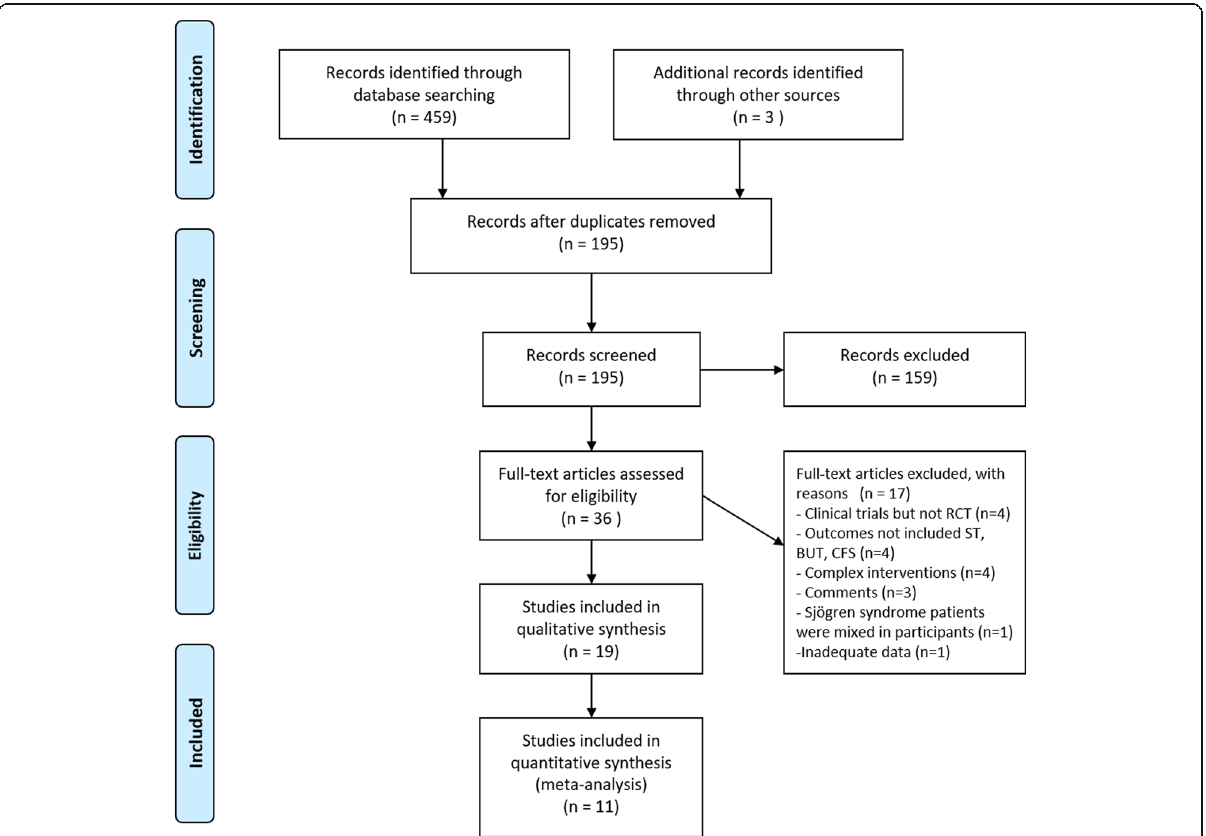
Fig. 1 Flow diagram of the systemic process for report